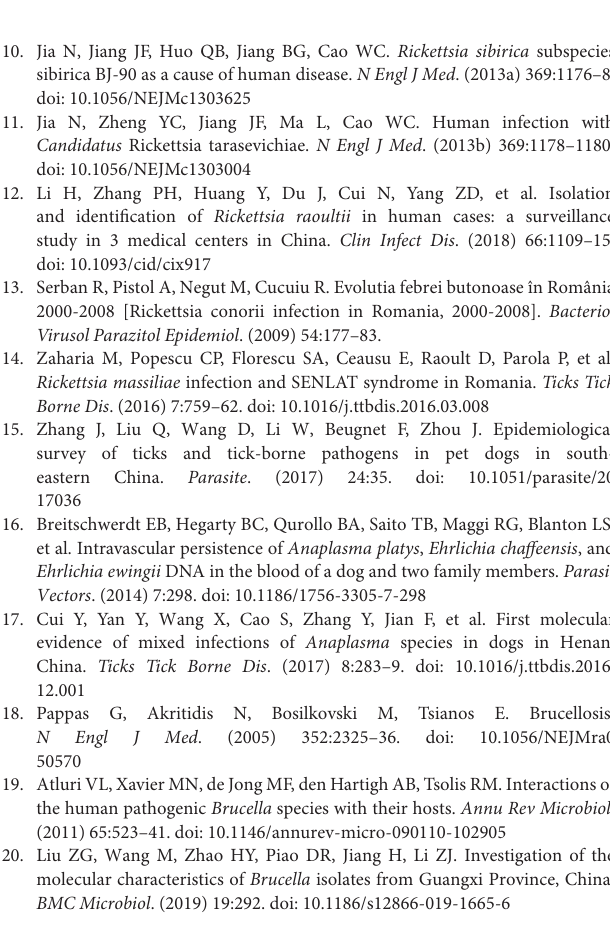
Supplementary Figure 1 | The morphological characteristics of male ticks collected from pet dogs. Supplementary Figure 2 | Phylogenetic tree based on cytochrome c oxidase subunit 1( COI ) sequences of ticks collected from pet dogs. New sequences obtained in this study are indicated by white triangles. Supplementary Figure 3 | Phylogenetic tree of Rickettsia species based on ompB gene within pet dogs and their ticks. New sequences obtained in this study are indicated in black diamonds. Supplementary Table 1 | GenBank accession numbers of representative nucleotide